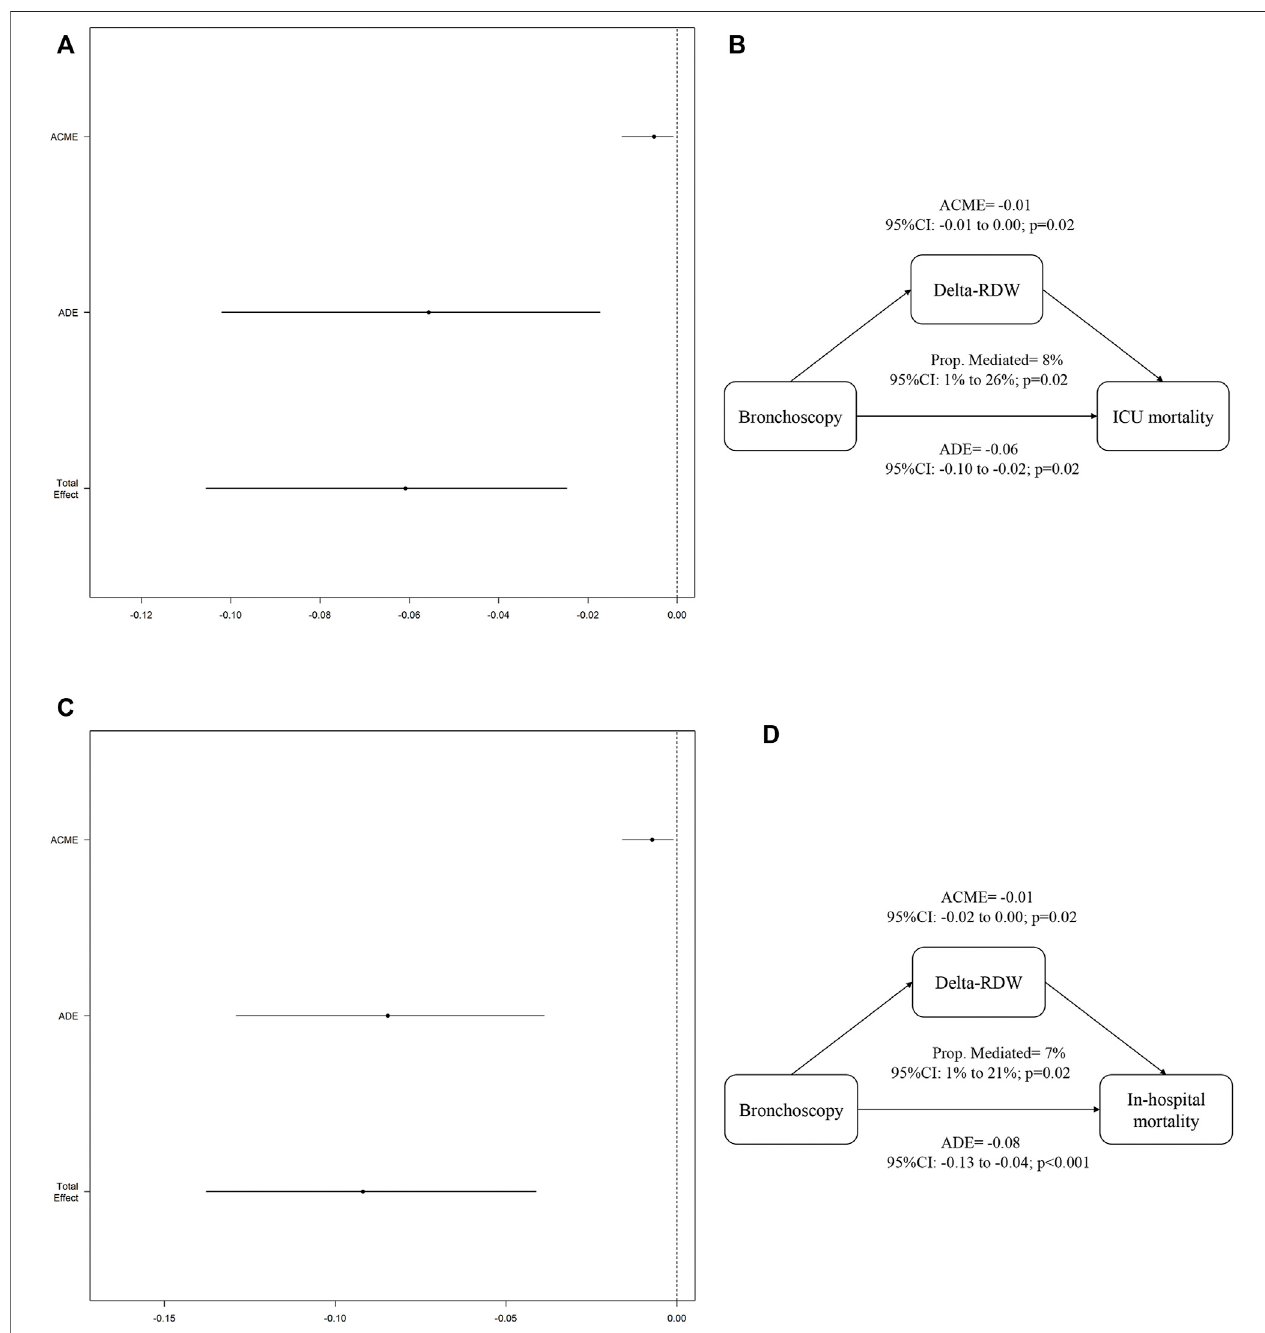
FIGURE 3 | Causal mediation analysis for RDW